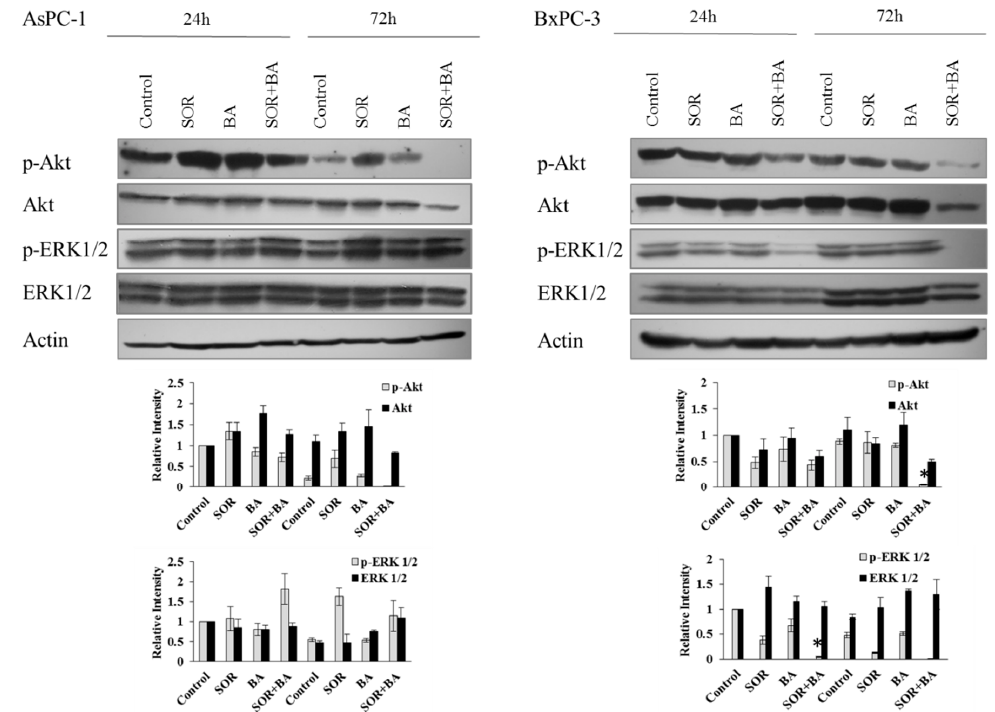
Figure 4. The effect of combination treatment with SOR and BA on protein expression of the PI3K/Akt and MAPK signaling pathways in human PDAC cell lines—AsPC-1 and BxPC-3. Representative immunoblot of phospho-Akt (Ser473), Akt, phospho-ERK1/2, and ERK1/2 expression from AsPC-1 and BxPC-3 cells treated with sorafenib (AsPC-1: 5 µM, BxPC-3: 3 µM) and betulinic acid (6 µM) alone and in combination ( n = 3). Actin served as a loading control. Data are presented as means ± SD. * p < 0.05 compared with the sorafenib treatment group and betulinic acid treatment group.